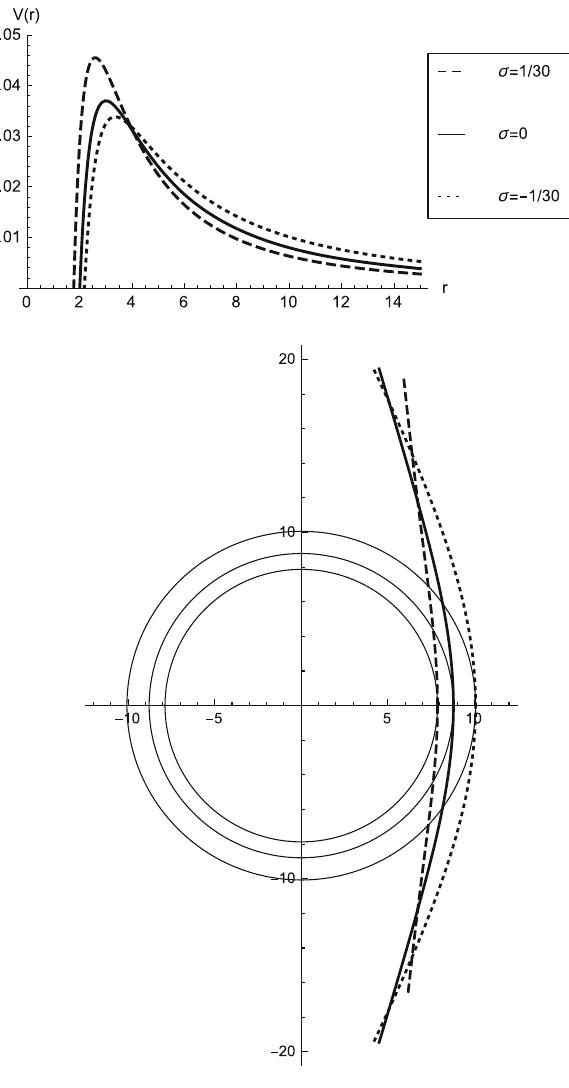
Fig. 4 The top panel shows the behavior of the effective potential for photons V(r) as a function of r , for different values of σ , with r S = 2 and L = 1. The bottom panel shows the trajectories for photons with E 2 = 0 . 01, and different values of σ